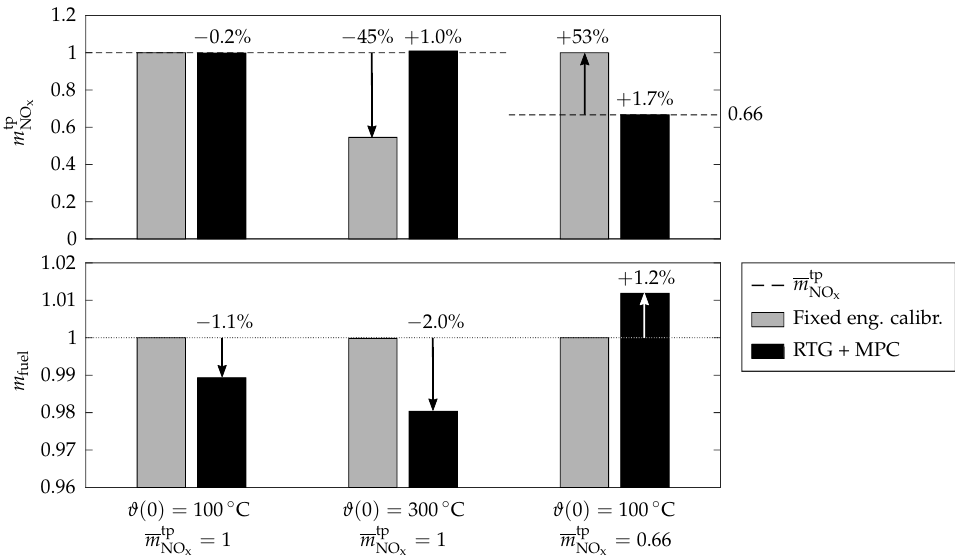
Figure 10. Comparison of the measured operation for the NRTC for different initial ATS temperatures and tailpipe NO x limits. The results obtained with the fixed engine calibration are shown in gray, while the results obtained with the predictive supervisory controller are shown in black. The results on the left and the right correspond to points on the Pareto front on the left of Figure 8. All values were normalized with respect to the operation with the fixed engine calibration for ϑ ( 0 ) = 100 ◦ C = and m tp NO x